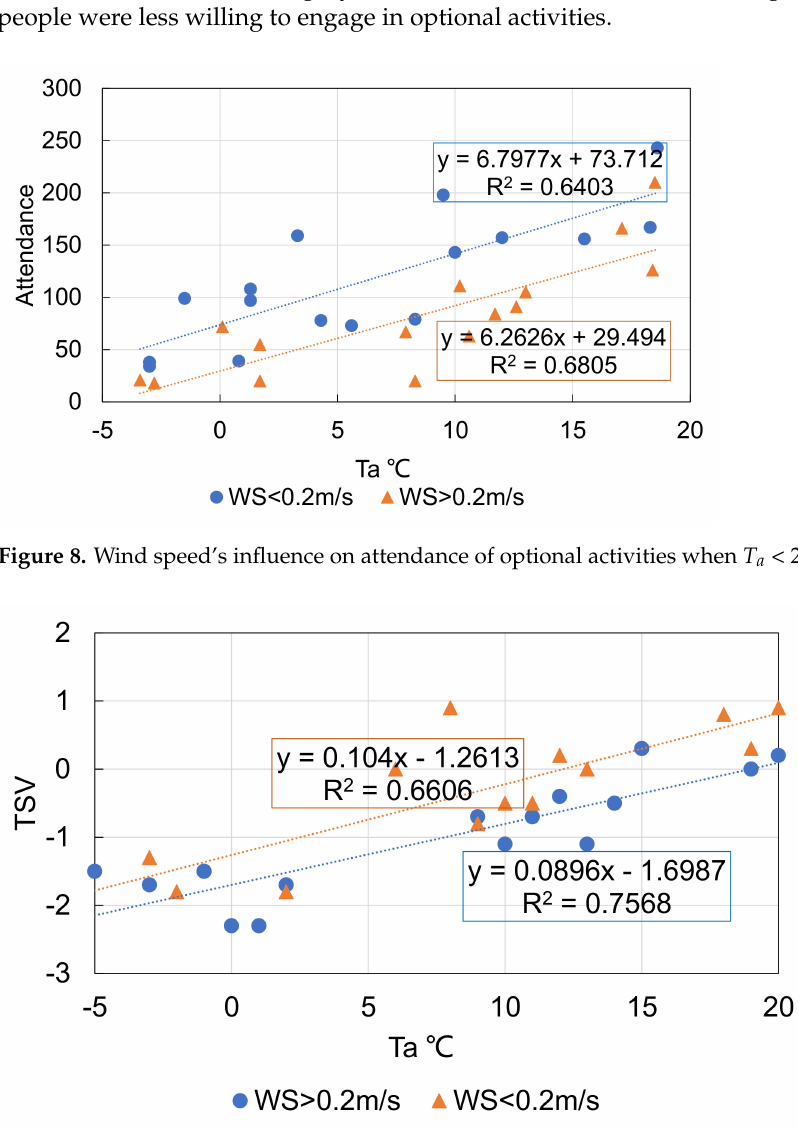
Figure 9. Wind speed’s influence on TSV when T a < 20 ◦